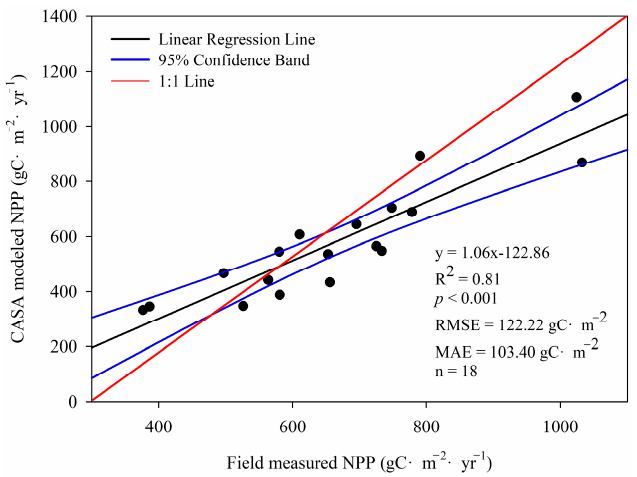
Figure 3. Validation of the CASA-modeled NPP results for the GBA. Note that the 95% confidence intervals of slopes for the CASA model range from 0.79 to 1.33.